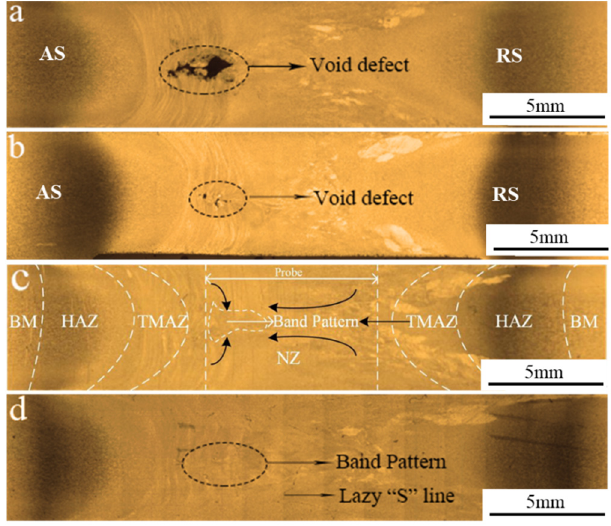
Figure 4. Cross-section morphology at welding speeds of: ( a ) 150 mm/min; ( b ) 250 mm/min; ( c ) 350 mm/min and ( d ) 450 mm/min.